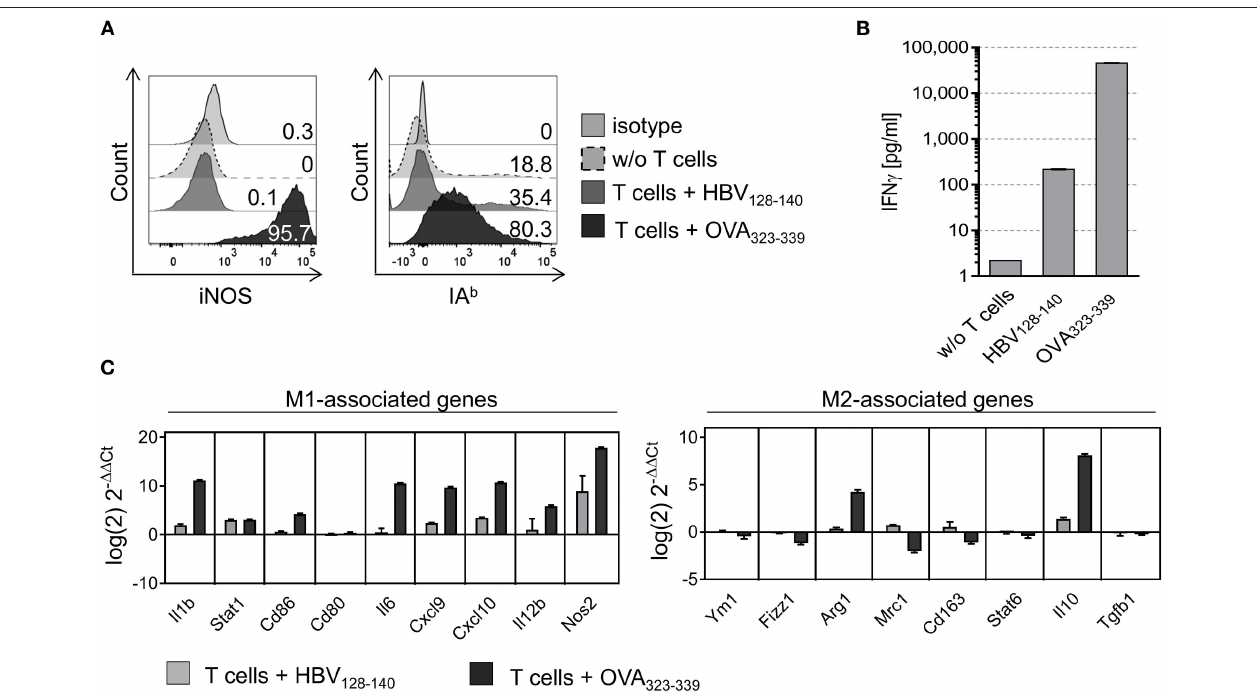
FIGURE 2 | M2-like PECs are repolarized upon cognate interaction with CD4 + T cells. PECs were cultured with IL-4 for 24h to induce M2 polarization. Subsequently, PECs were loaded with 1 µ g/ml IA b restricted epitope OVA 323 − 339 or with HBV 128 − 140 control epitope and co-cultured with an OVA-specific CD4 + T cell line for 24h. (A) FACS analysis of co-cultured PECs using iNOS and IA b specific monoclonal antibodies showing strong upregulation of both M1 markers. Gating strategy: living cells → single cells (FSC-A vs. FSC-H) → F4/80 + CD11b + → IA b vs. FSC-H. (B) IFN γ ELISA showing that IFN γ concentration increased 20,000 fold in culture supernatants of M2 polarized PECs co-cultured with CD4 + T cells plus relevant peptide compared to PECs cultured without T cells. (C) Gene expression analysis revealed M1 repolarization of M2-like PECs upon co-culture with CD4 + T cells in presence of specific peptide. Expression data was normalized to PECs w/o T cell addition. Error bars represent SD of technical